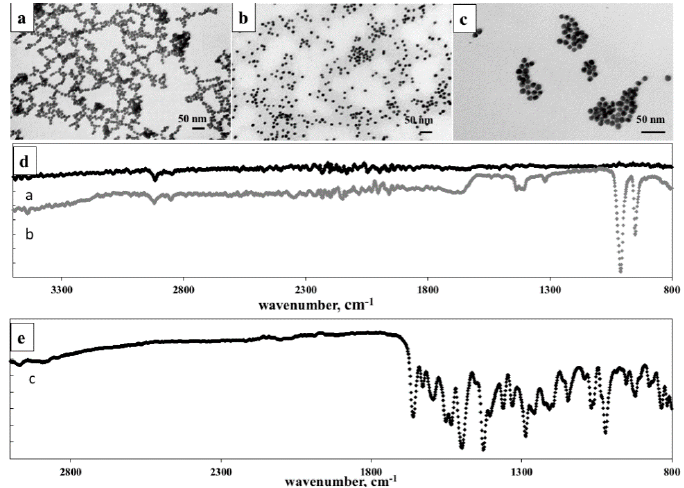
Figure 1. TEM images of ( a ) AuNPs, ( b ) PEGAuNPs, ( c ) PEGAuNPsVarl. Scale bar is 50 nm; ( d ) FTIR spectra of PEGAuNPsVarl (black line) and PEGAuNPs (grey line), ( e ) FTIR spectra of varlitinib (black dots). The spectra were shifted for a better visualization.